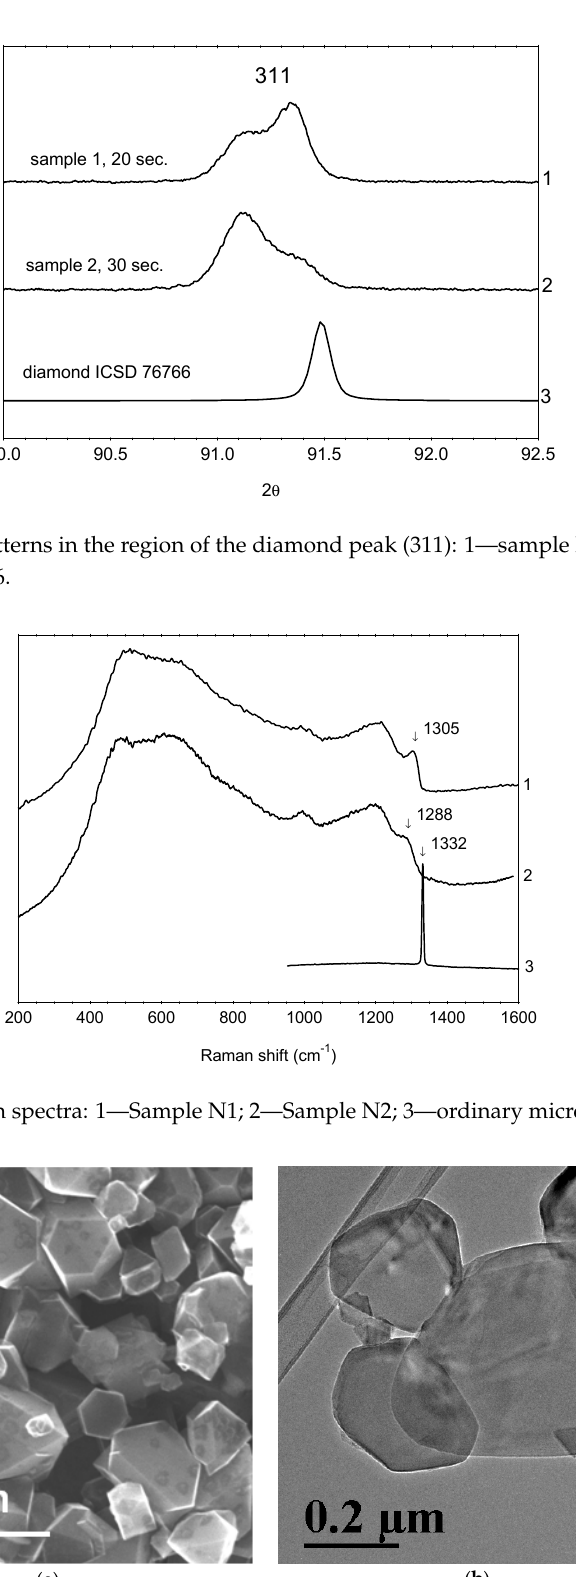
Figure 3. Morphology of boron doped diamond crystals. Synthesis from a mixture of globular nano-carbon and M-carborane. ( a ) SEM; ( b ) TEM.